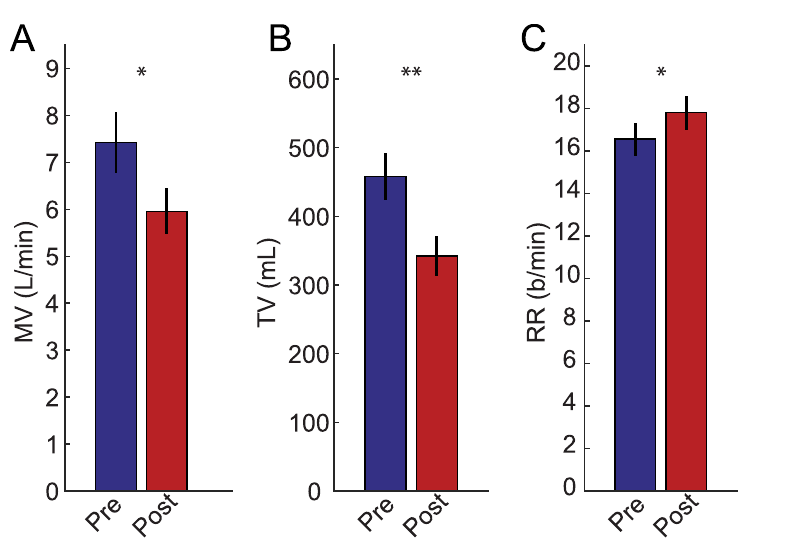
Fig 1. Average RVM measurements across the entire thirty patient cohort pre (left) and post (right) administration of 2mg of midazolam. ( A ) MV decreased significantly from 7.41 ± 0.62 L/min (mean ± SEM) to 5.95 ± 0.46 L/min, with an averagedecreaseof 14.3% ± 5.9% (p < 0.05). ( B ) Similarly, TV decreases significantly from 460 ± 30 mL to 340 ± 30 mL, an averagedecreaseof 22.3% ± 4.5% (p < 0.001). ( C ) In contrast, RR increasedslightly from 16.6 ± 0.7 breaths per minute to 17.8 ± 0.7 breaths per minute, an averageincrease of 10.3% ± 4.7% (p <